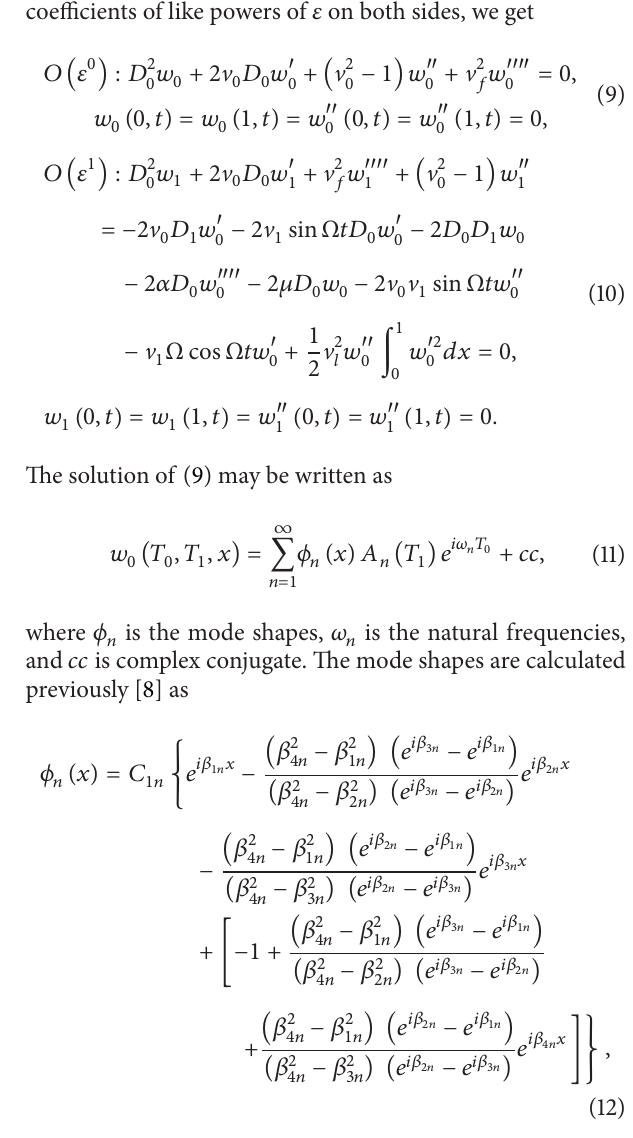
Figure 2: Trivial state boundary for different damping parameters. Values of the nondimensional damping parameters (𝜇,𝛼) , indicated on the